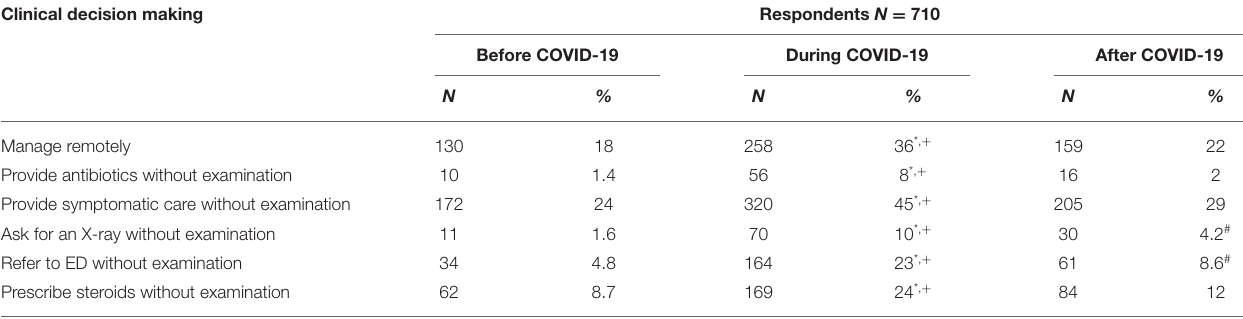
TABLE 3 | High likelihood pattern of clinical decision making in scenario